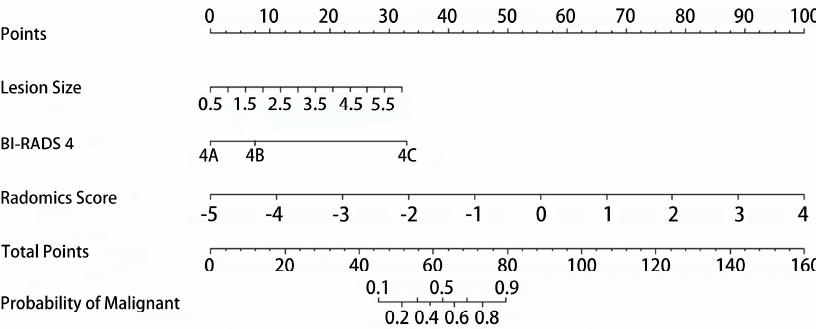
Figure 3. Radiomic nomogram. The radiomic nomogram was developed by combining the radiomic score, lesion size and BI-RADS 4 subcategory to distinguish benign and malignant BI-RADS 4 le- sions.